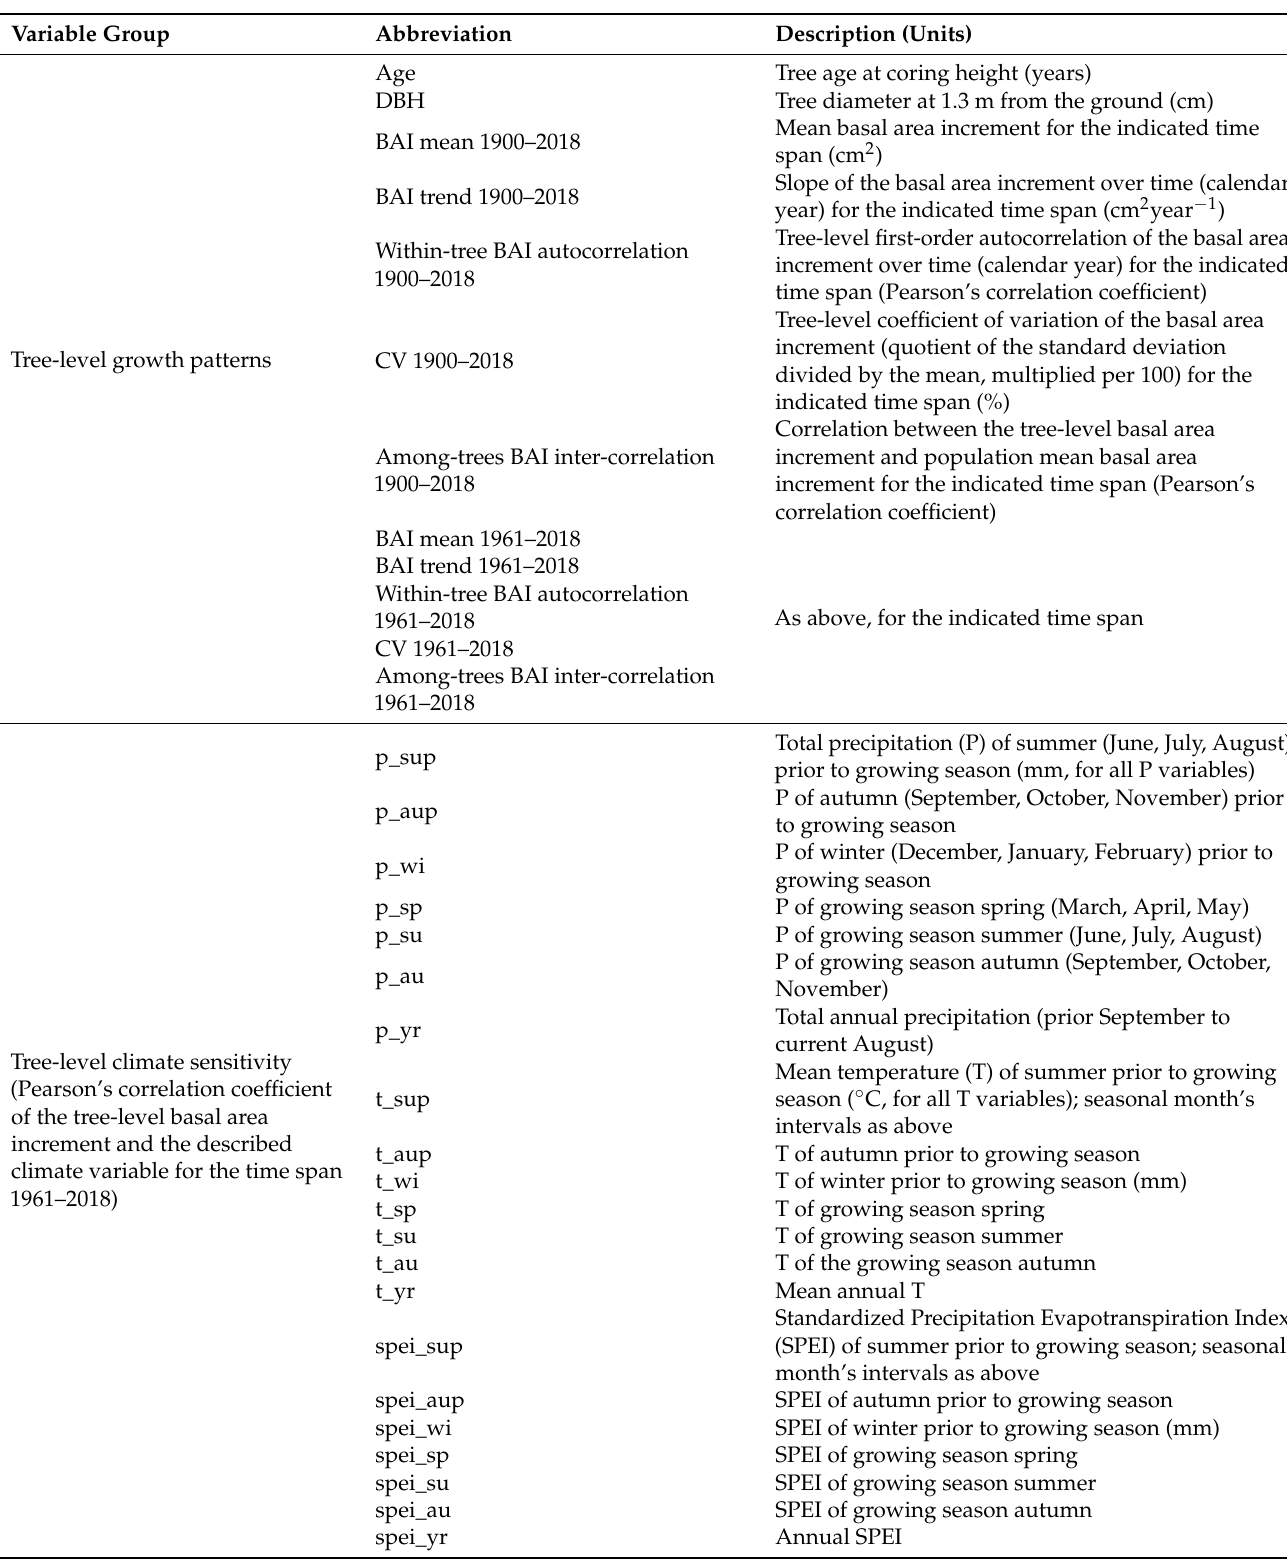
Table 4. Dendrophenotypic traits used in the genotype–phenotype associations (GPA) to relate tree-level growth patterns and climate sensitivity with the single nucleotide polymorphisms (SNPs)